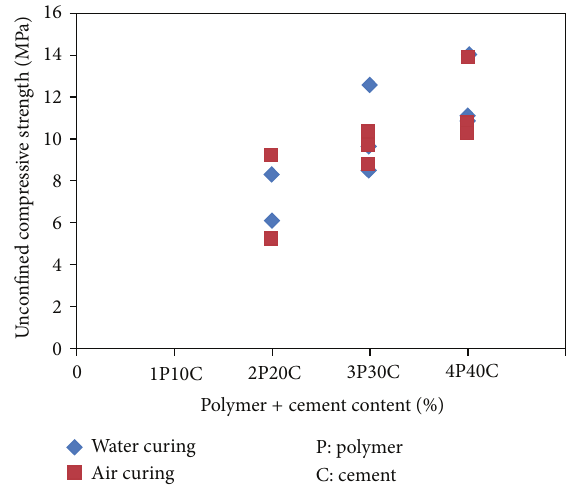
Figure 7: Unconfined compressive strength of soils modified with cement and polymer.